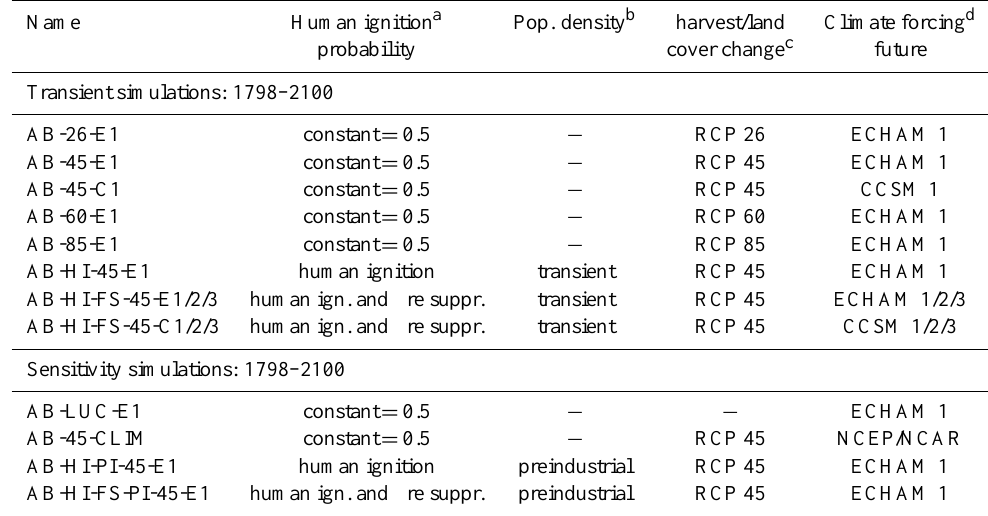
a Different treatment of human ignition probability: either a constant value of 0.5, allowing for human ignition as a function of population density (HI), or human ignition and fire suppression (HI-FS). b Population density was allowed to vary between 1798 and 2100 (for 1798 to 2004 following Klein Goldewijk (2001), from 2005 onwards scaled with the SRES A1 projections for the SRES world regions (CIESIN, 2002)) or was held constant at a preindustrial